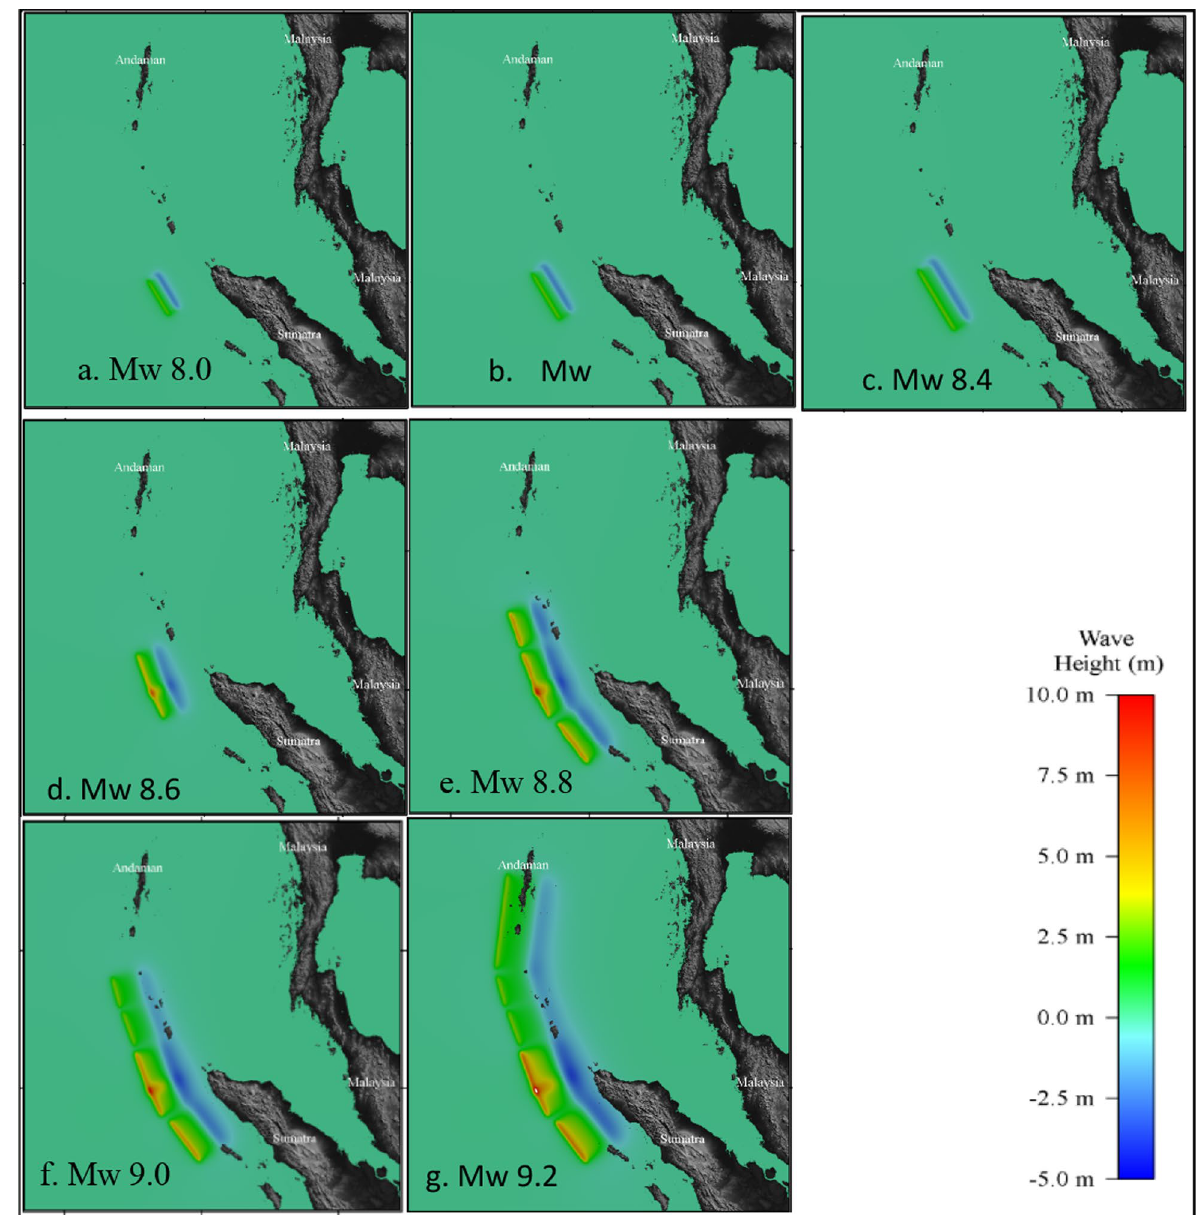
Fig. 3 Initial tsunami height with seven scenarios of earthquake magnitude, from Mw 8.0 ( a ) to Mw 9.2 ( g